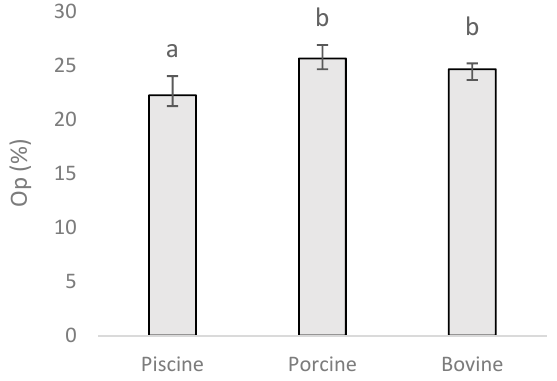
Figure 5. Opacity of bioplastics generated from piscine, porcine, and bovine gelatines. Values repre- sent an average of n = 3; error bars represent standard deviation with lowercase letters representing significantly different values.